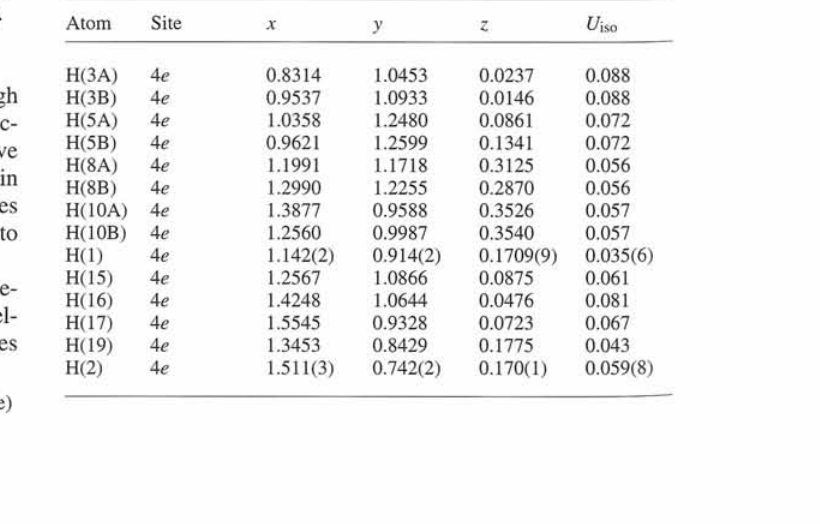
Table 2. Atomic coordinates and displacement parameters (in Â 2